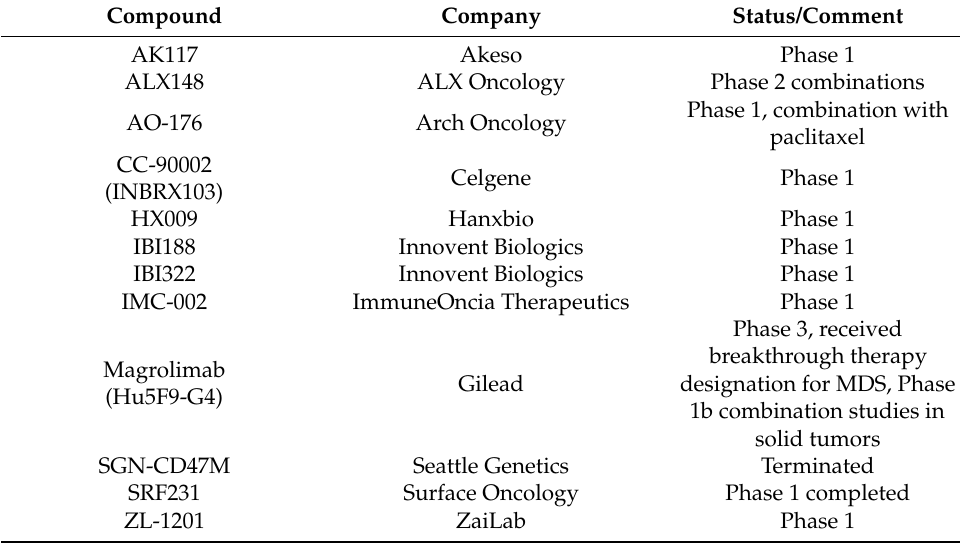
Table 5. Anti-CD47 antibodies in early clinical